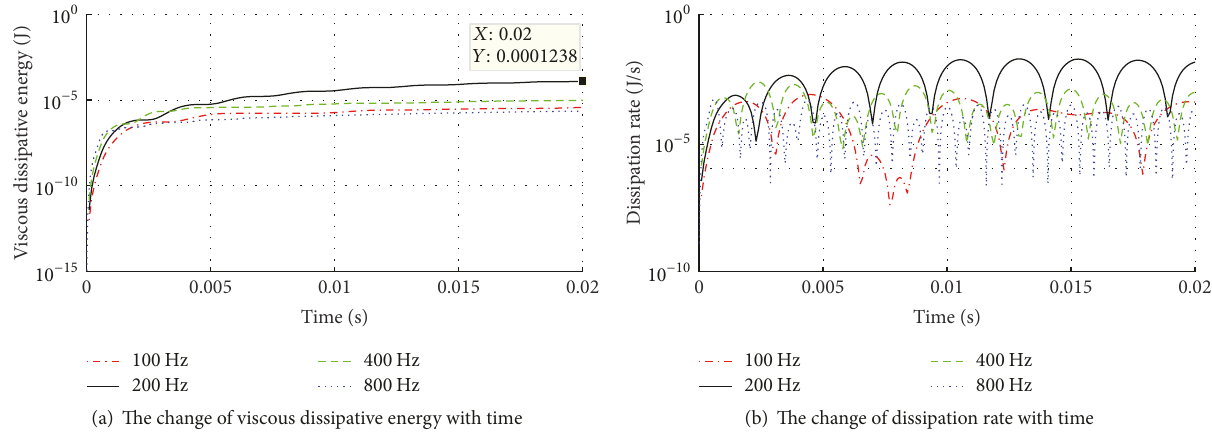
Figure 8: Energy dissipation characteristics of spacecraft multifunctional structure under harmonic excitation.